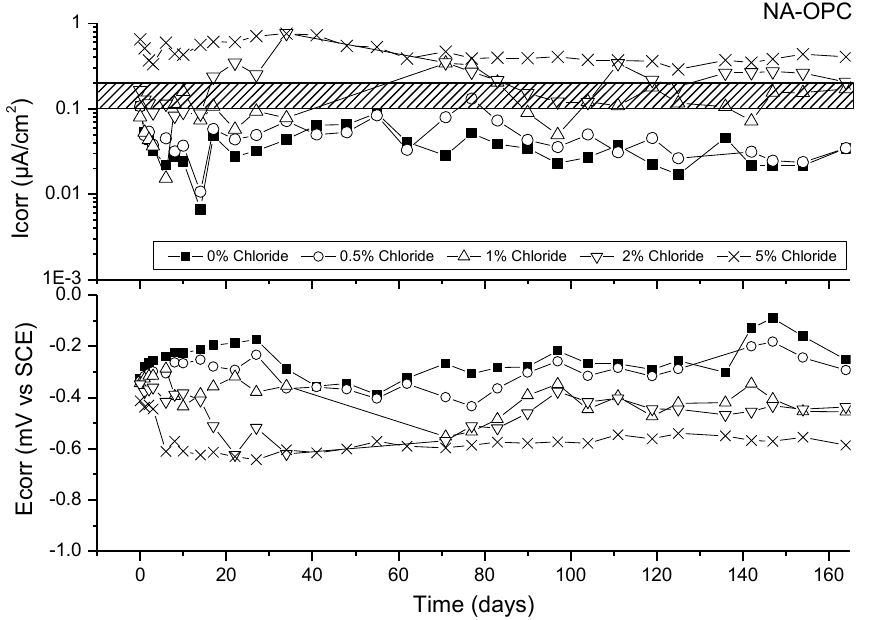
Figure 6. Corrosion rate and corrosion potential of steel reinforcement embedded in NA-OPC specimens and different chloride concentrations.